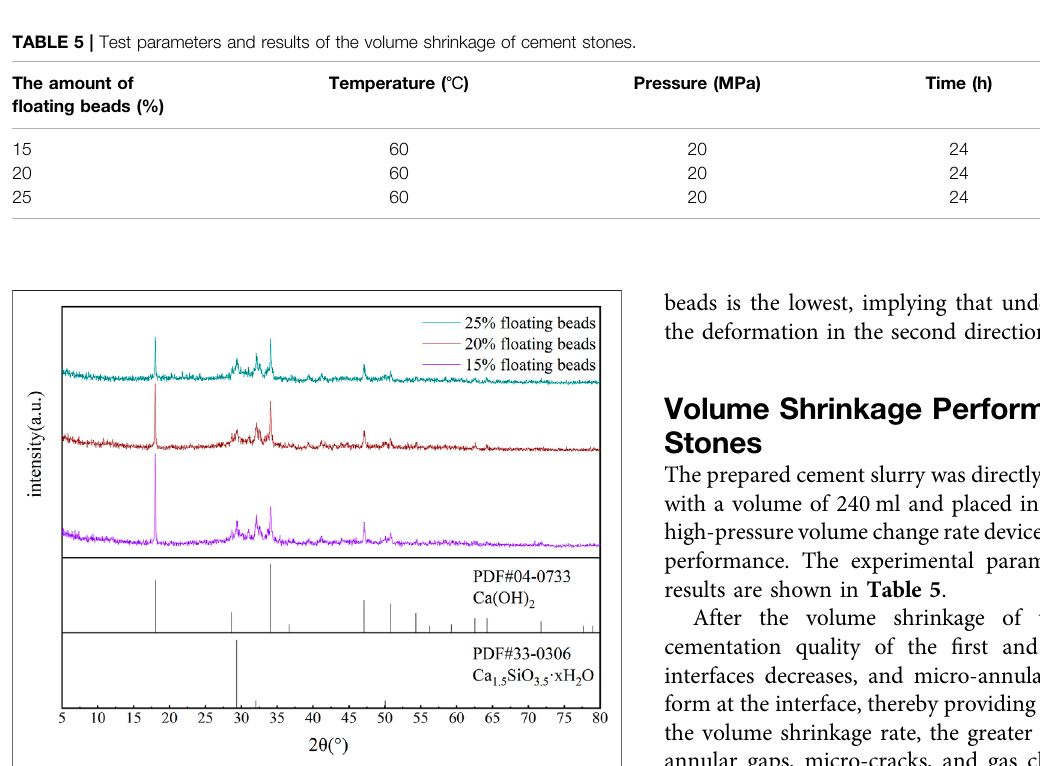
Frontiers in Materials |